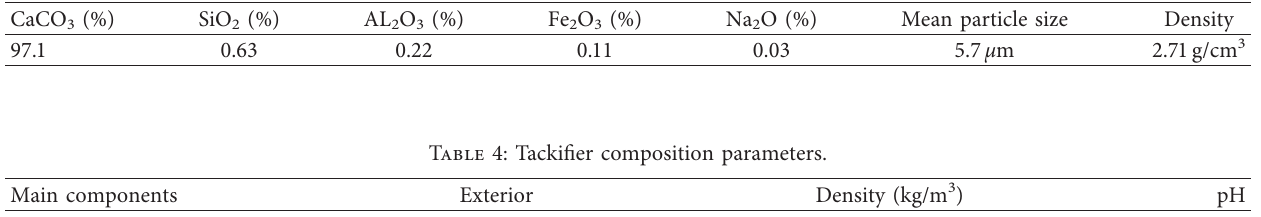
Table 3: Chemical composition and physical properties of the filler.